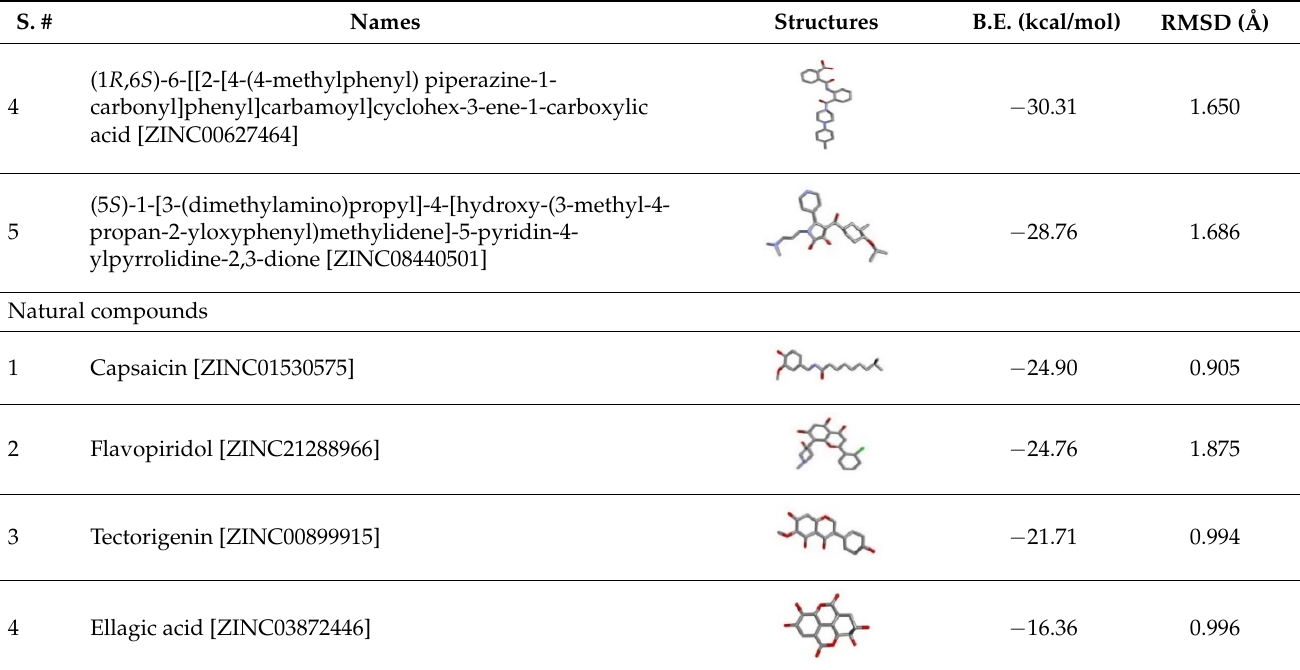
Sv. Scoring value, B.E. Binding energy, RMSD. Root-mean-square distance, S. #. Serial number. Progesterone and testosterone were used as a negative control group as their scoring values are − 23.53 and − 23.95 respectively, as shown in Table 3. Previous research reveals that adding an androgen to estrogen treatment lowers mammary epithelial proliferation and ER expression, implying that androgens may protect against breast cancer in the same way as progesterone does. In the past, androgens were used to treat breast cancer with moderate effectiveness [45]. There are mixed theories about these hormones, as some claim they down-regulate breast cancer progression, whereas some claims they up-regu- late the process. However, according to our studies, both progesterone and testosterone have shown interactions with ER alpha protein. Furthermore, this study reveals that these hormones may up-regulate breast cancer development, as they interacted at the active site of ER-alpha with binding energies of − 23.53 (progesterone) and − 23.95 (testosterone). Up- regulation of breast cancer due to an imbalance of these hormones has already been re- ported. It has been reported that the effects of sex hormones on breast cancer development are clear from the advantages of hormone withdrawal treatment, with particular evidence of a relationship between completion of hormone withdrawal and clinical benefit [46].